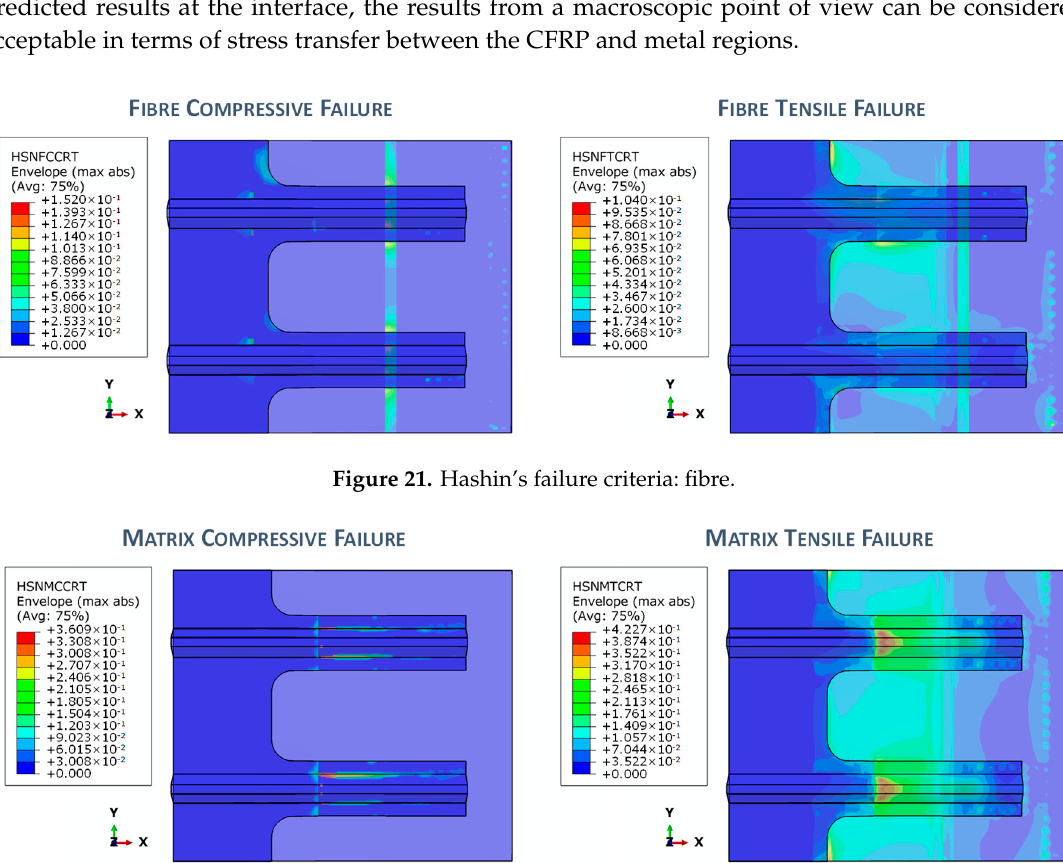
Figure 23. Plastic strains — load: 300 kN.